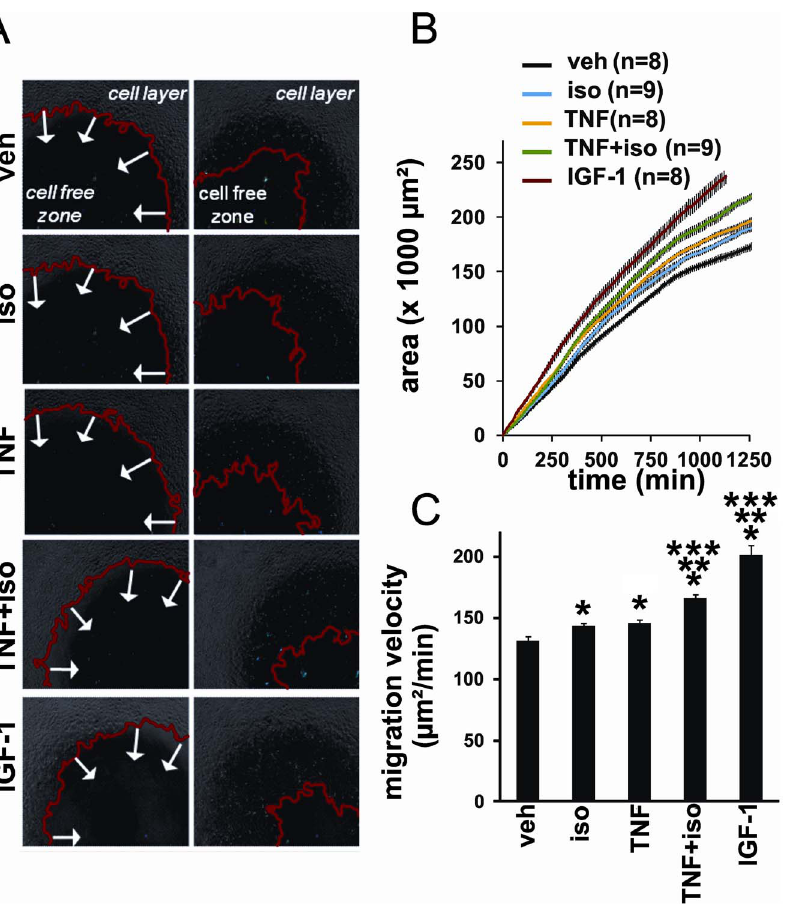
Figure 6. C2C12 myotubes secrete factors that promote the migration of C2C12 myoblasts. C2C12 myotubes were treated for 24 hours with veh, iso and/or TNF. Conditioned medium was prepared as described in Materials and Methods and applied to C2C12 myoblasts. Recombinant IGF-1 was used as a positive control. Cell migration was monitored for 24 hours. (A) Selected start and end phase contrast images for the different conditions from a representative experiment. The red line delineates the confluent cell layer that migrates inwards in time; arrows show migration direction into the cell-free zone. (B) Cell-covered area over time plot from a representative experiment. The lines represent the mean area for technical replicates (n indicated in the Figure); error bars are SEM. (C) Mean migration velocity (n replicates, see data in B) for the tested conditions in a representative experiment. (Relative migration efficiencies based on the cumulated data of three independent biological experiments are shown in Figure S4). Error bars are SEM. Statistical analysis was performed using Wilcoxon pairwise comparison with Bonferroni correction for multiple testing. (*) Significantly different from veh. (**) Significantly different from TNF. (***) Significantly different from iso.